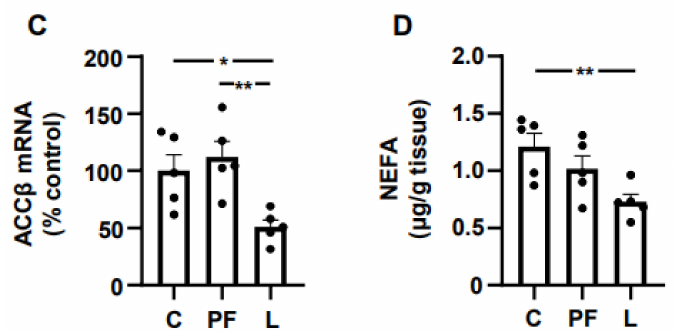
Figure 5. Changes in lipid metabolism markers after leptin infusion. Activity of ( A ) glucose 6-phosphate dehydrogenase (G6PD) and ( B ) malic enzyme, ( C ) acetyl-CoA carboxylase (ACC) β mRNA levels and ( D ) non-esterified fatty acid (NEFA) content in the gastrocnemius of control rats (C), pair-fed rats (PF) and rats receiving chronic intracerebroventricular leptin infusion (L). Data are pre- sented as means ± SEM. * p < 0.05, ** p < 0.01; one-way ANOVA followed by Bonferroni’s test. Dots represent the individual data.